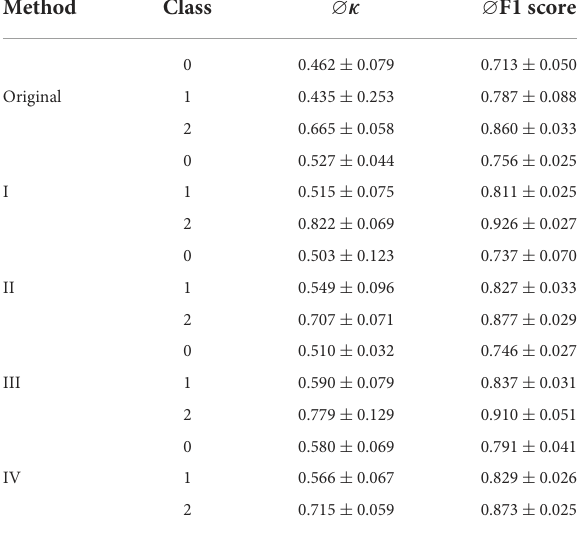
TABLE 4 Average Cohen’s kappa values and F1 score in each class per